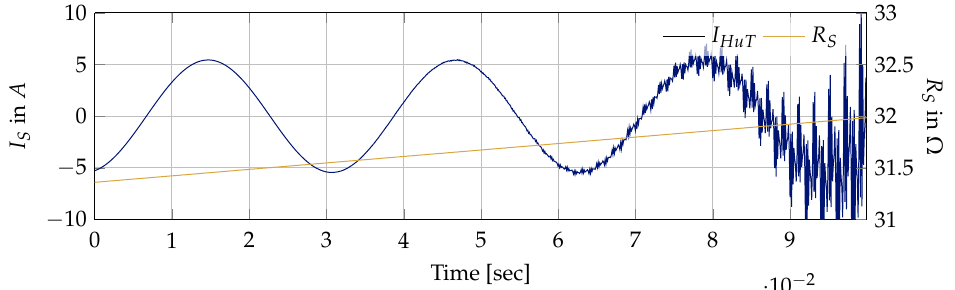
Figure 17. Feedback current with rising R S until stability limit is